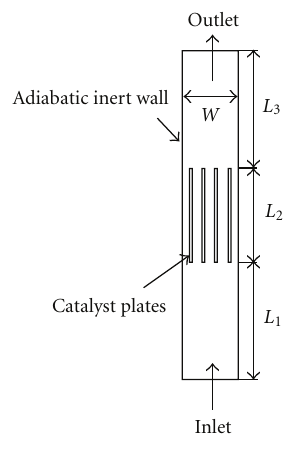
Figure 1: Simplified geometry for CFD